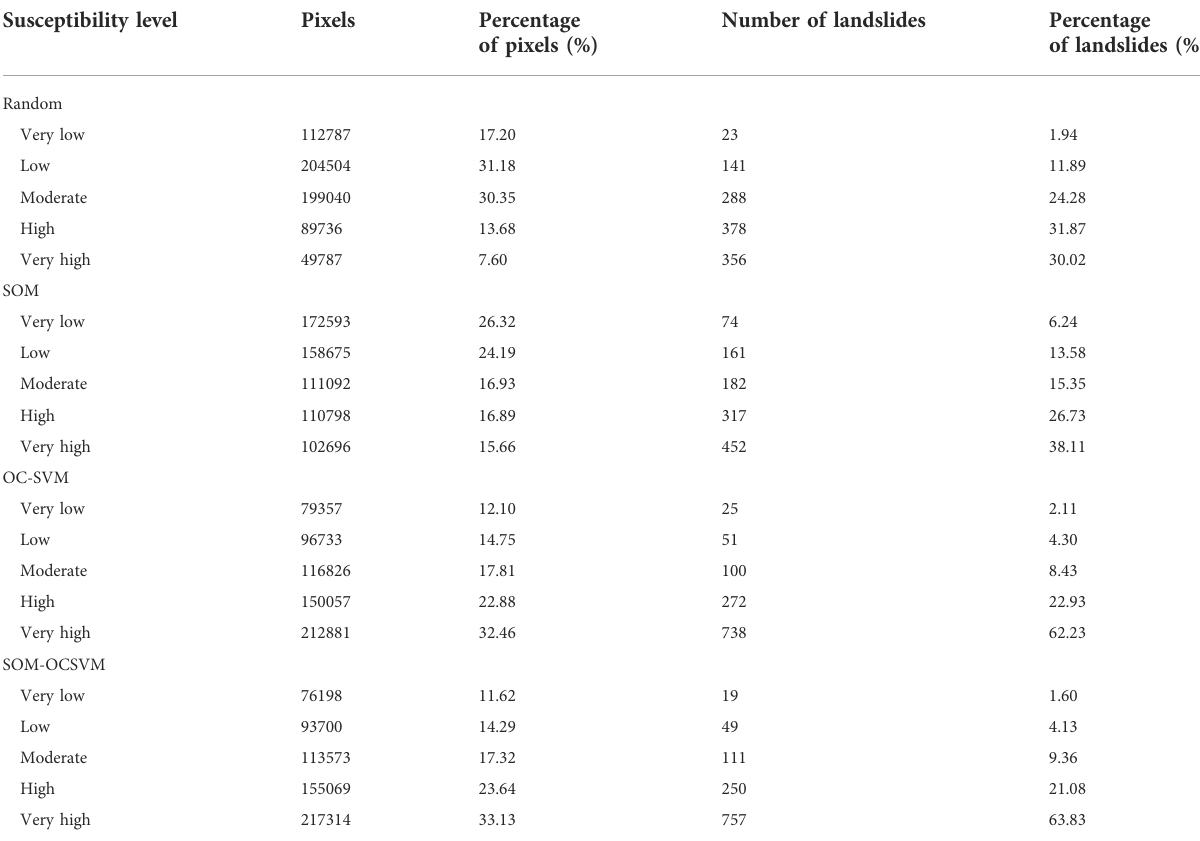
TABLE 2 Landslide susceptibility levels and percentage of landslides in the study area.